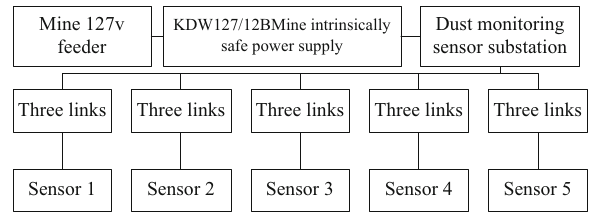
Fig. 2 Arrangement of sensors to measure dust concentration in roadway excavation: 1-Sensor 1. 2-Sensor 2. 3-Sensor 3. 4-Sensor4. 5-Sensor 5. 6-Air cylinder. 7-Tape conveyor.